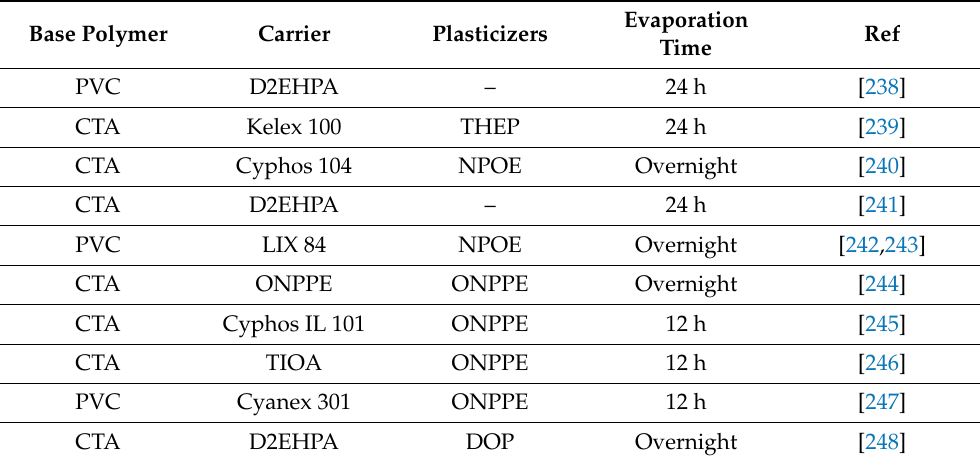
Table 12. Materials for PIMs [237]. Reproduced with permission from Keskin, B.; Zeytuncu-Göko˘glu, B.; Koyuncu, I, Chemosphere; published by Elsevier, 2021.